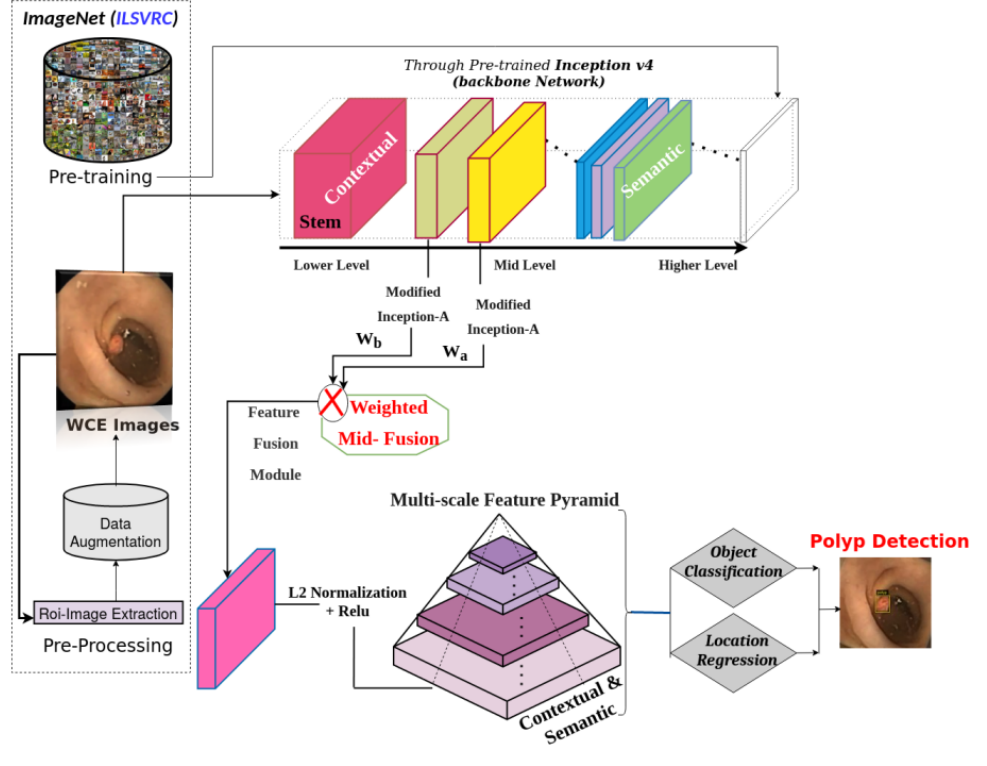
Figure 2. Flowchart of the proposed Hyb-SSDNet method for small polyp detection in WCE